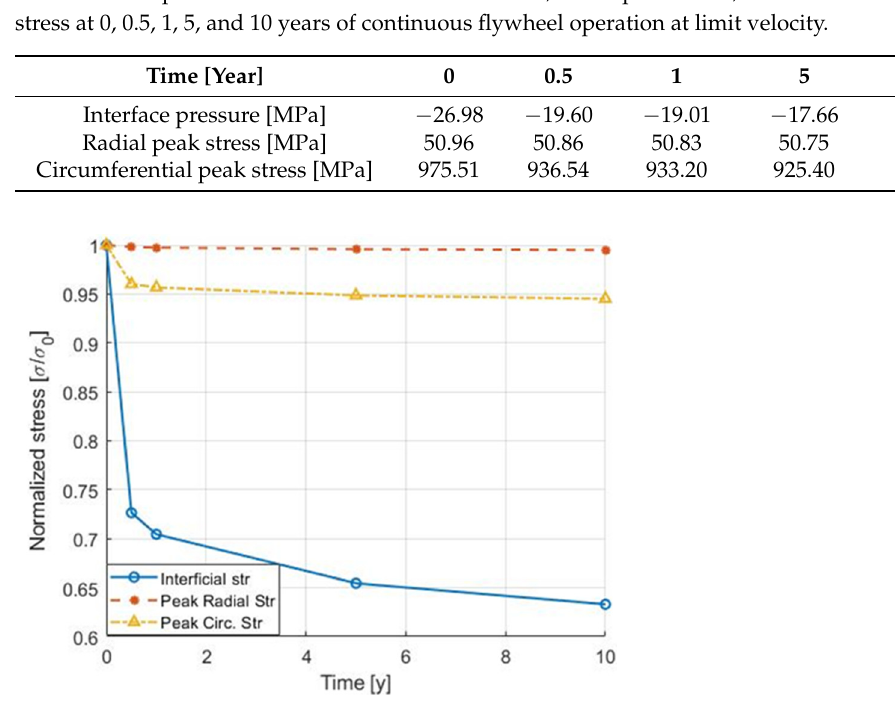
Figure 4. Normalized rotor peak stress for interfacial pressure, radial stress, and circumferential stress over time for continuous flywheel operation at limit velocity. Values are normalized by the corresponding stress at time t = 0.